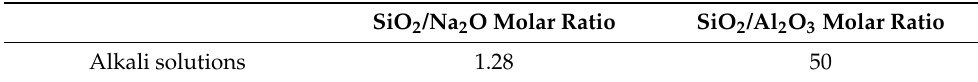
Table 3. Alkali solutions condition.